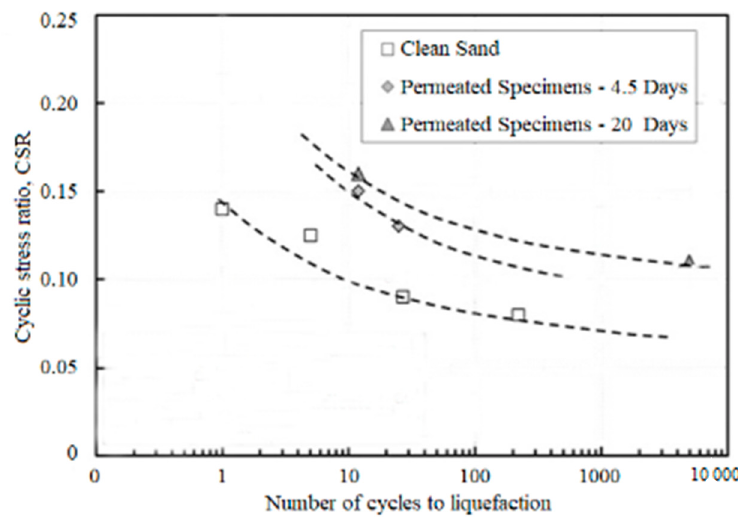
Figure 2. The relationship between cyclic stress ratio (CSR) and number of cycles to liquefaction for bentonite-treated samples with different curing time [25].